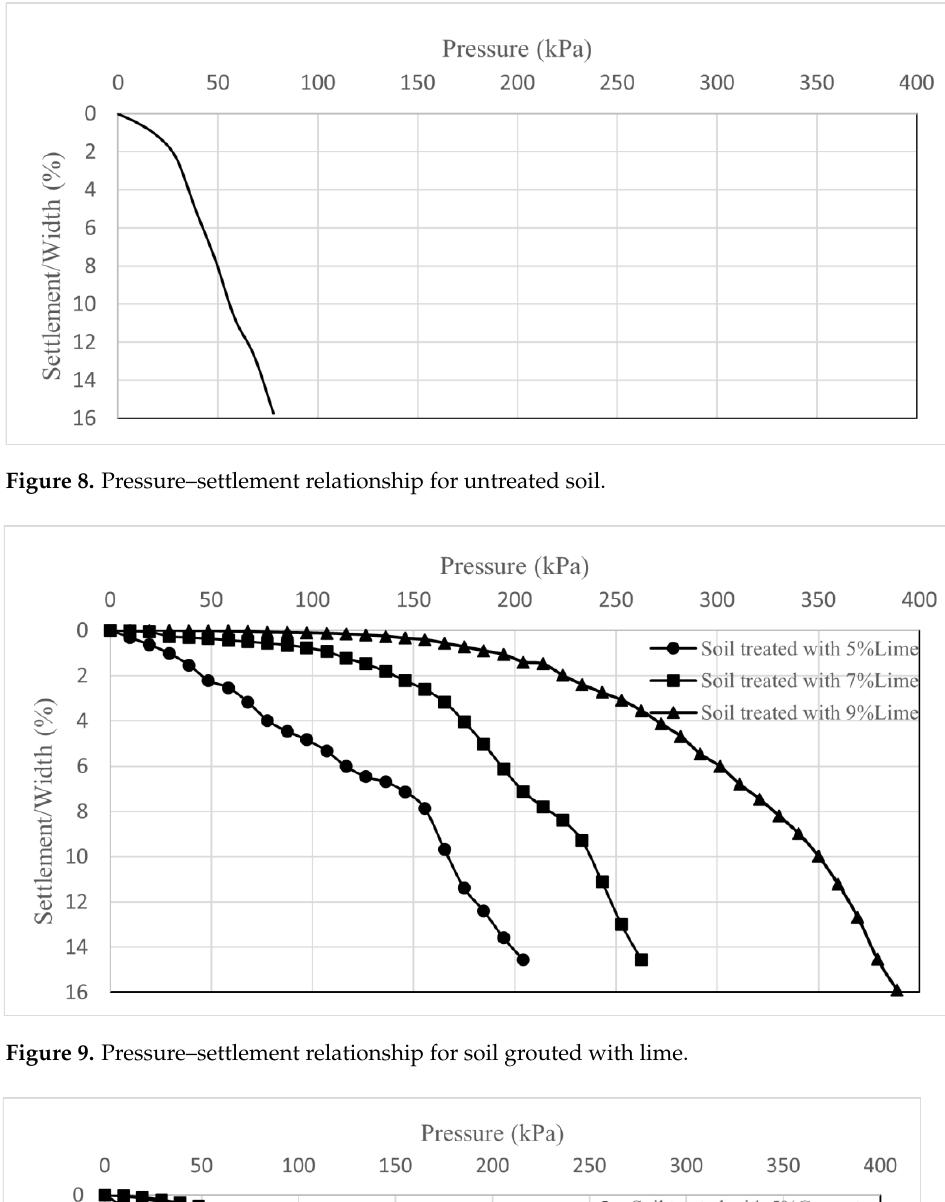
Figure 11. Pressure – settlement relationship for soil grouted with silica fume. The bearing capacity ratio is defined as follows: 𝐵𝐶𝑅 =